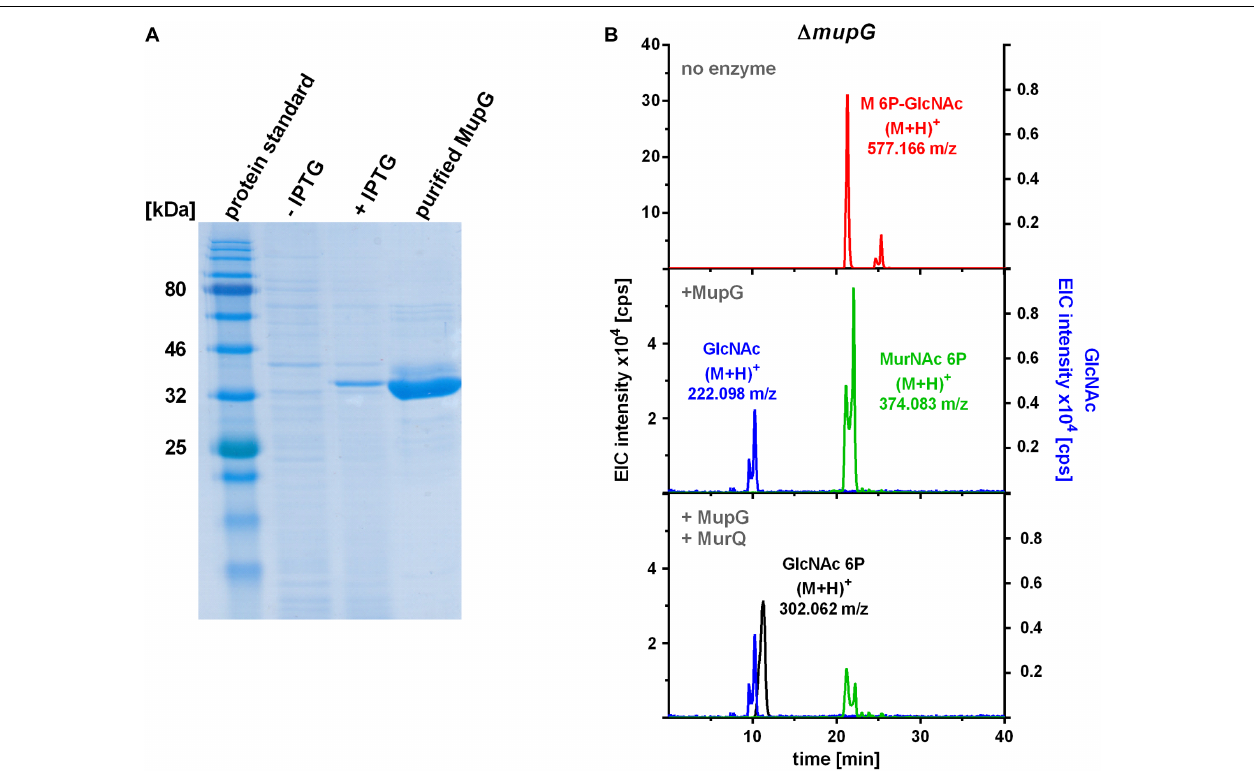
FIGURE 4 | Production of recombinant MupG and enzymatic digest of MurNAc 6P-GlcNAc extracted from (cid:49) mupG cytosolic fractions. (A) MupG from S. aureus JE2 strain was heterologously expressed in E. coli BL21(DE3) cells. Protein expression, before (-IPTG) and after induction for 3 h (+IPTG), and purity (after purification by Ni 2 + -affinity and size exclusion chromatography) was controlled by SDS-PAGE (5 µ g of the recombinant MupG protein was loaded). MupG-His 6 protein has a calculated molecular weight of 41.5 kDa. (B) S. aureus (cid:49) mupG cells were grown in LB medium for 24 h. Acetone extracts of the cytosolic fractions were analyzed by LC-MS in positive ion-mode. Fifty microliter of the cytosolic fraction from (cid:49) mupG was incubated with buffer (no enzyme), with 1 µ g recombinant MupG (+MupG) or with MupG and MurNAc 6P etherase MurQ (both 1 µ g) for 2.5 h at 37 ◦ C. Representative mass spectra of the samples from at least three biological replicates were presented as extracted ion chromatograms (EIC × 10 4 [cps]) for MurNAc 6P-GlcNAc (observed masses of (M+H) + = 577.166 m/z) in red, GlcNAc ((M+H) + = 222.098 m/z) in blue, MurNAc 6P ((M+H) + = 374.083 m/z) in green and GlcNAc 6P ((M+H) + = 302.062) in